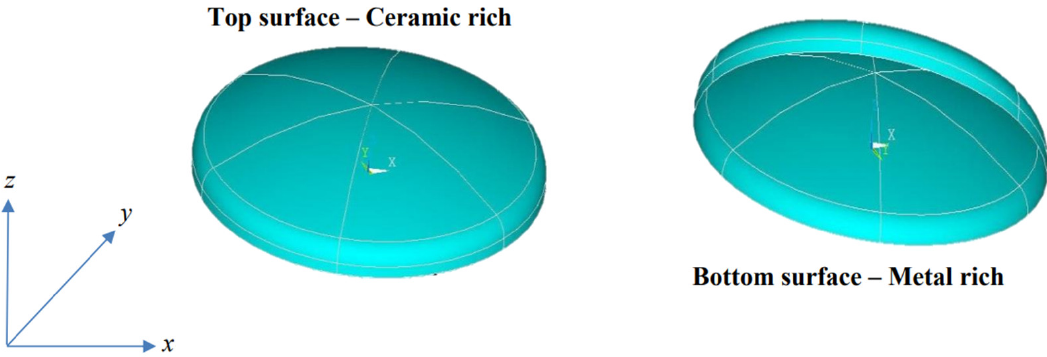
Figure 2. Schematic representation of the FGM shell structure, which forms the nose of re-entry vehicle in the present study.